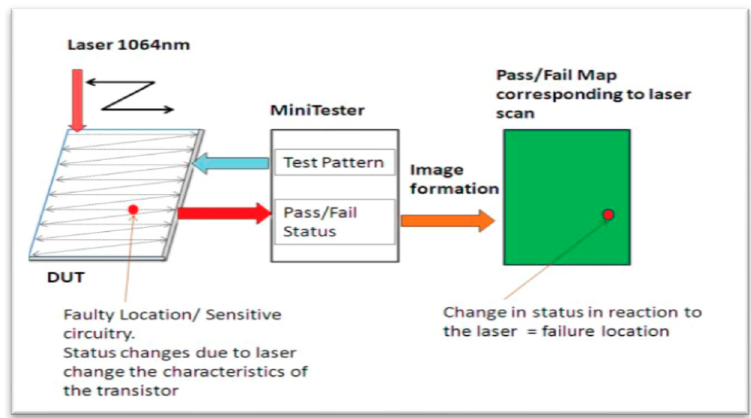
Figure 15. The pass/fail map using LADA.